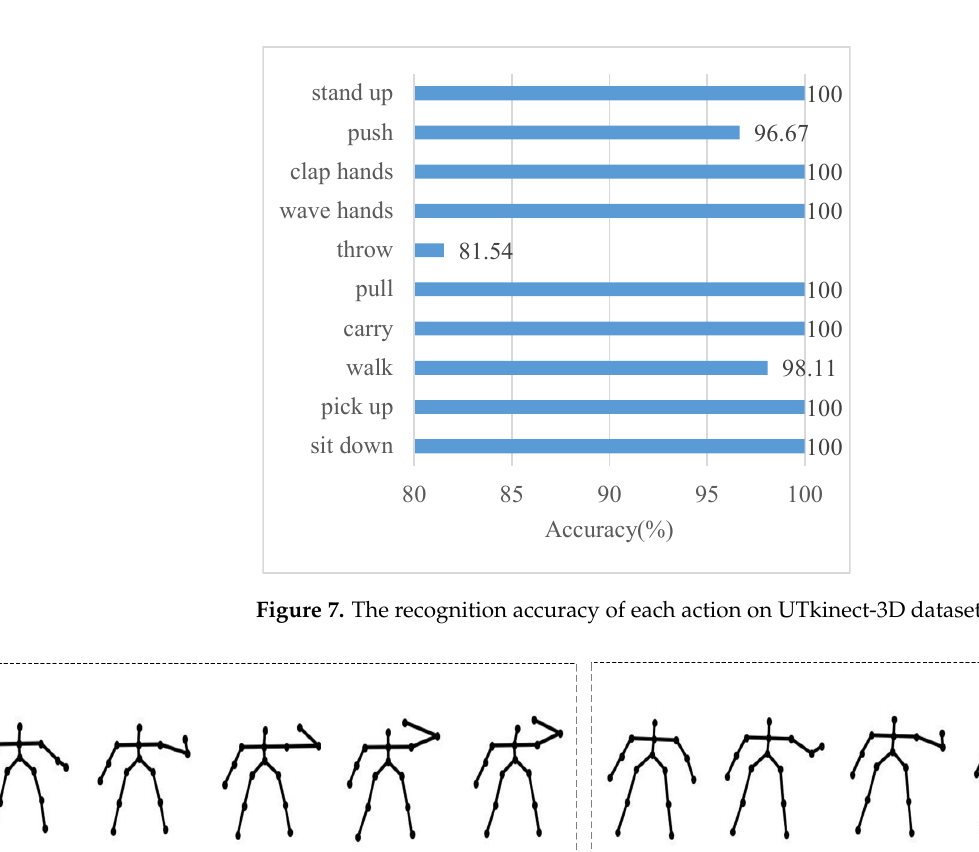
Figure 6. The recognition accuracy of each action on Florence-3D dataset using our method.